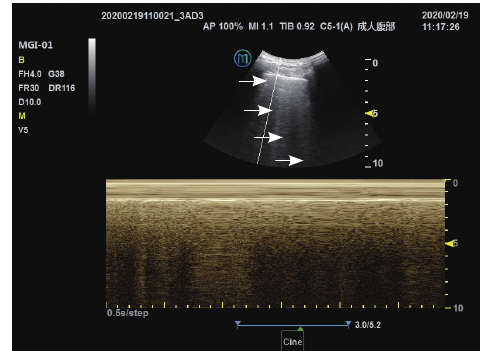
Figure 3 Lung ultrasound on a patient with confirmed COVID-19 by robot-assisted teleultrasound base on 5G network. M-mode ultrasound was applied on the right anterior lower lung. The upper part of the image displays the two-dimensional ultrasound, showing increasing B-lines (arrows). The lower part of the image displays the M-model ultrasound, indicating the presence of lung